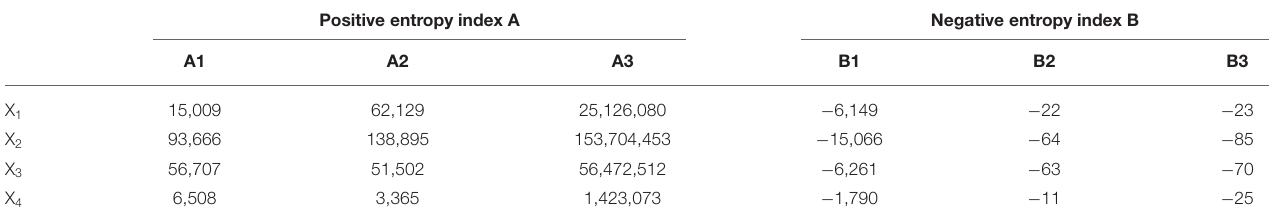
TABLE 2 | Original values of positive and negative entropy